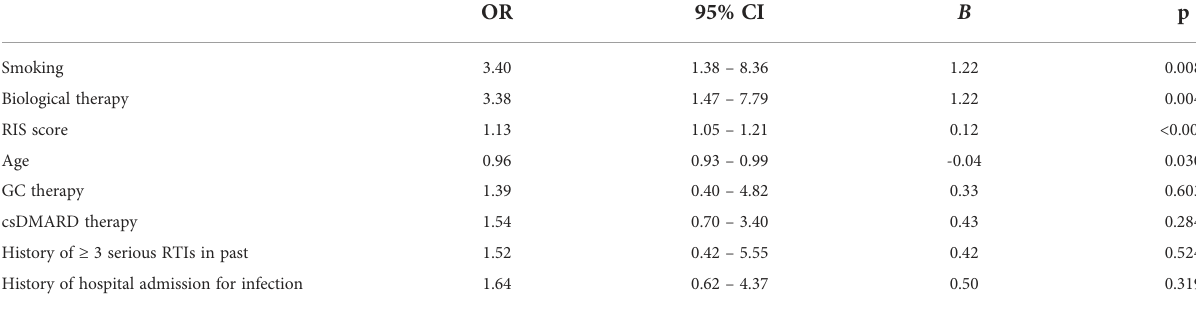
TABLE 3 Multivariate logistic regression analysis of factors associated with antibiotic